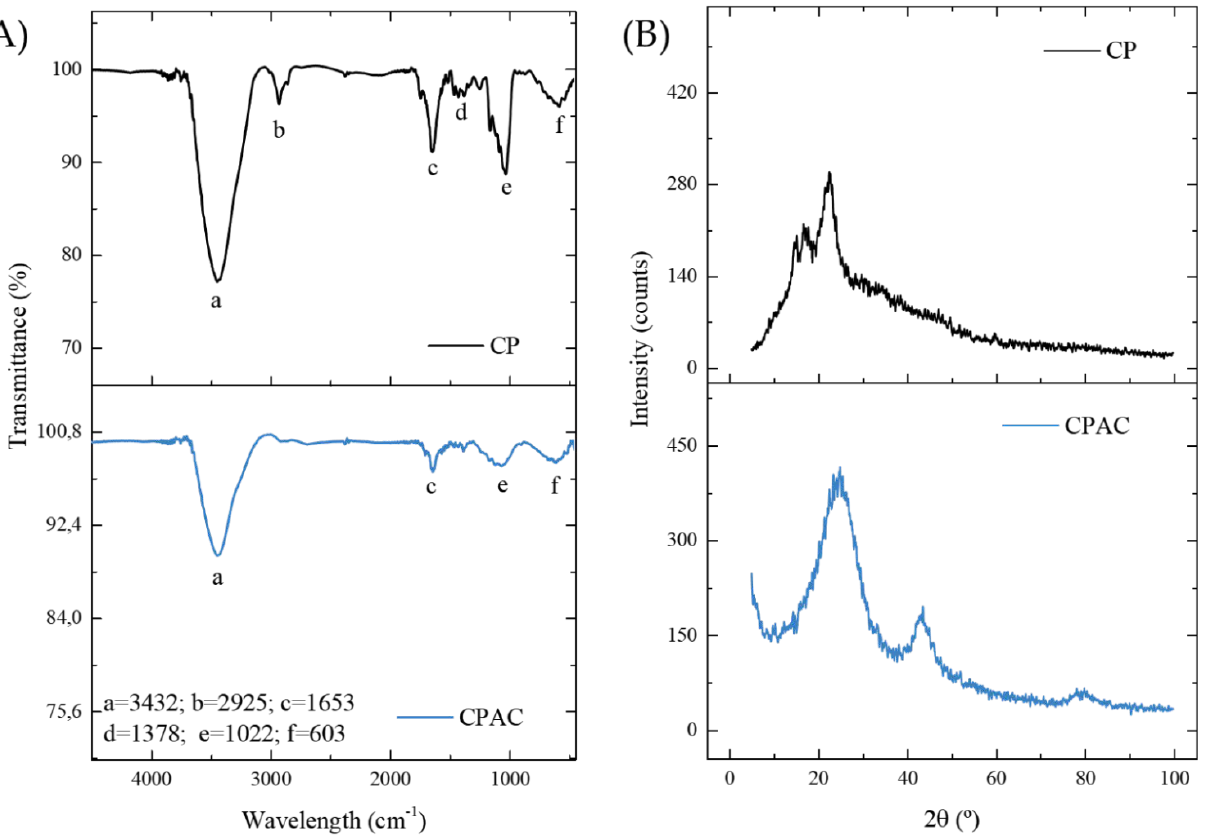
Figure 1. FTIR spectra ( A ) and XRD ( B ) patterns for CP and CPAC samples.